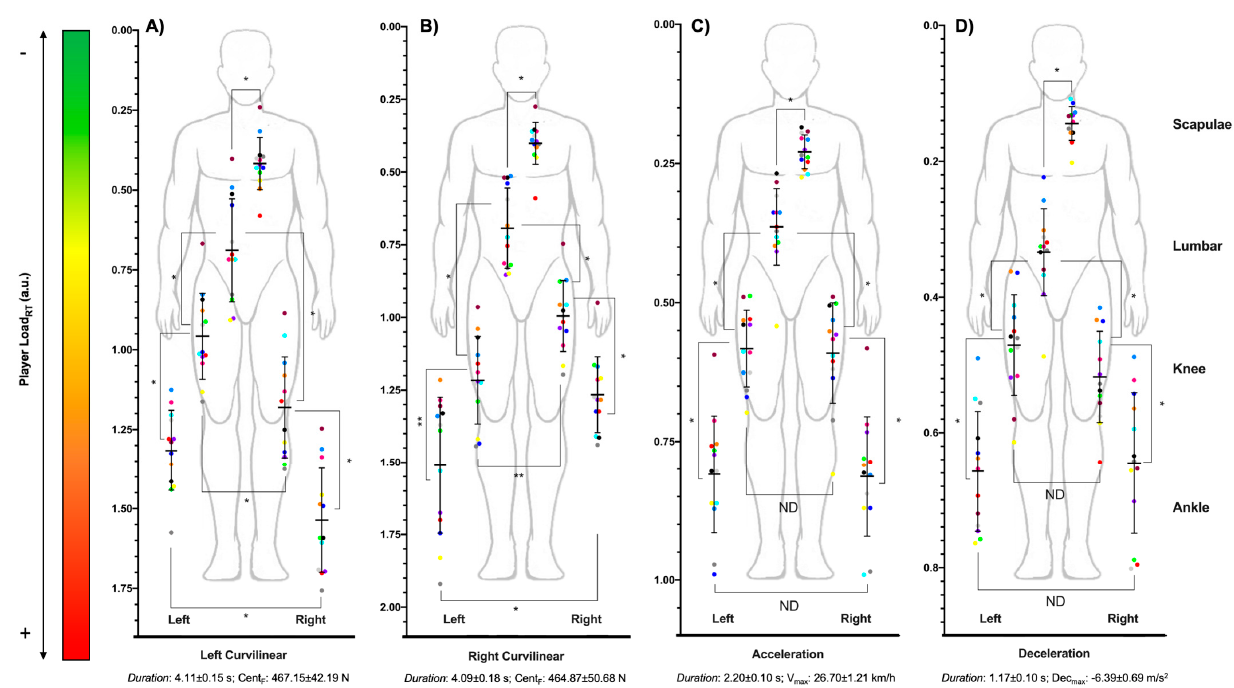
Figure 1. Scatter dots plot with mean (black line), whiskers (standard deviation) and dots (basketball players) to represent the multi-location external workload profile of semi-professional male basketball players in curvilinear movements (( A ) left and ( B ) right direction) and speed changes (( C ) acceleration and ( D ) deceleration). * Statistical differences ( p < 0.05); ND: no statistical differences.